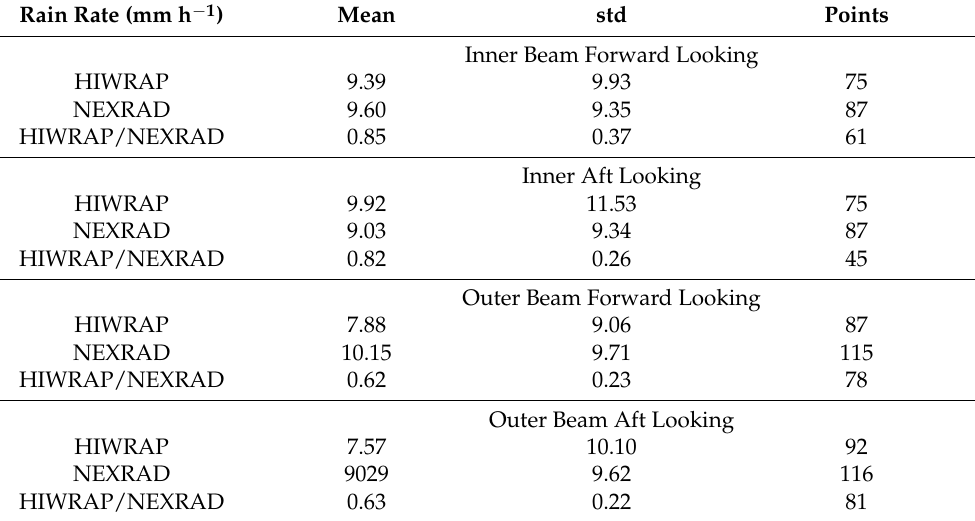
Table 1. Rain rate for 2 km gridded cells > 1 mm h − 1 (Figure